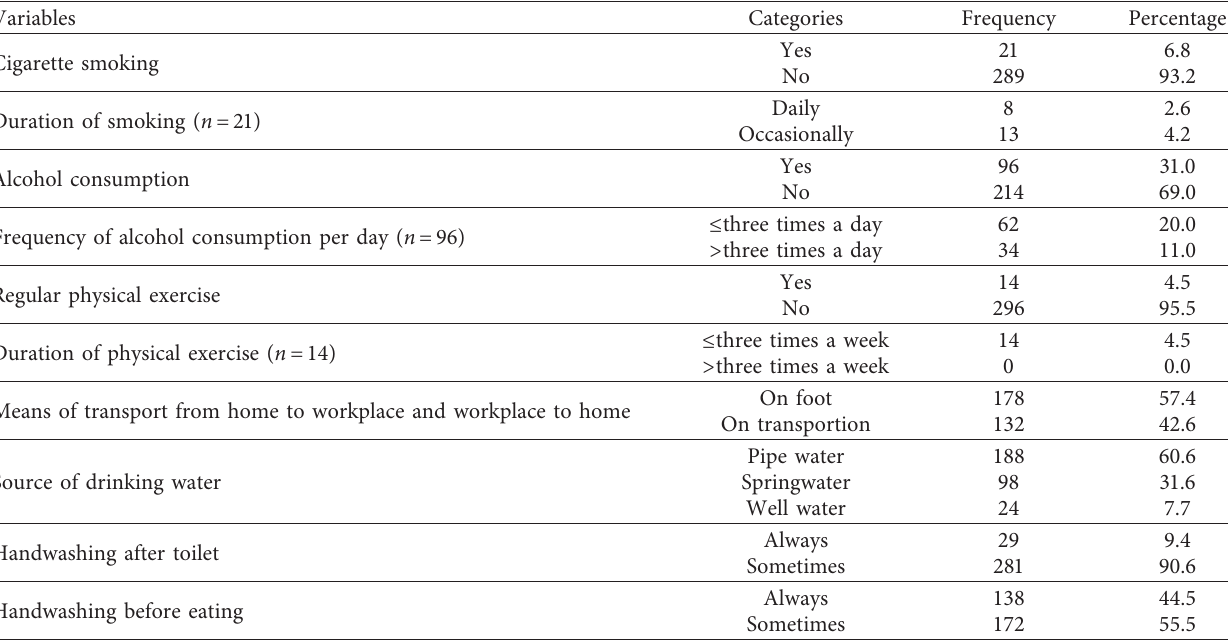
Table 2: Lifestyle of adult patients undergoing abdominal surgery at Bahir Dar City Public Hospitals, Northwest Ethiopia, 2019 ( N � 310). Variables